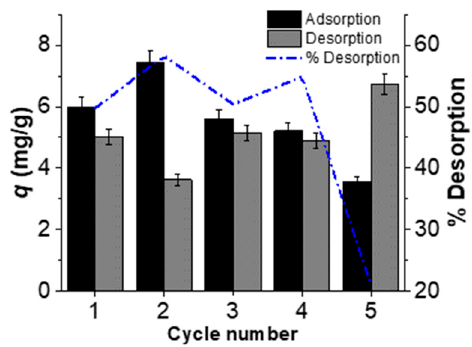
Figure 4. Adsorption and Desorption cycles of cadmium from MAAC beads (mean ± SE of 15 replicates).